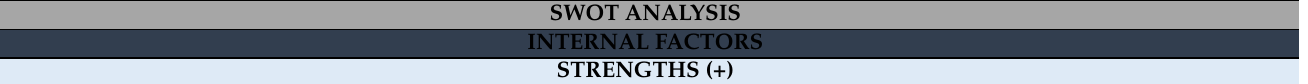
Table 1. SWOT analysis of the IPM of sunflower downy